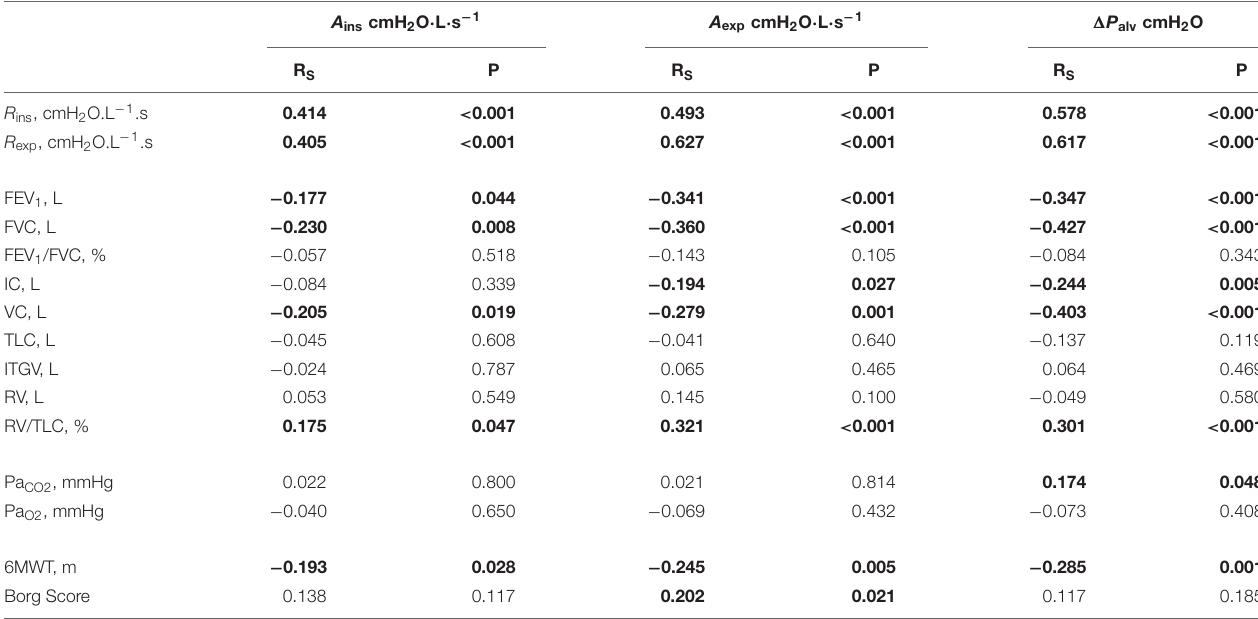
TABLE 4 | Dependencies of loop-derived parameters in COPD